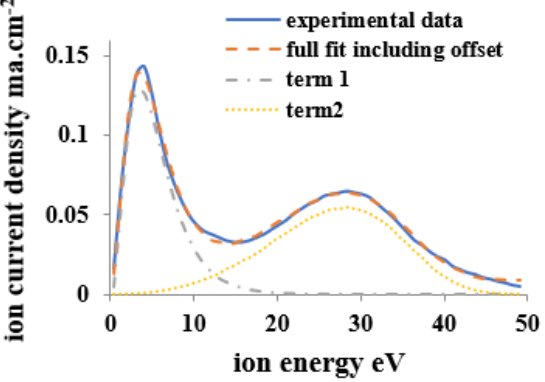
Figure 3. Plasma source measured Ion Energy Distribution Function ( IEDF) function.